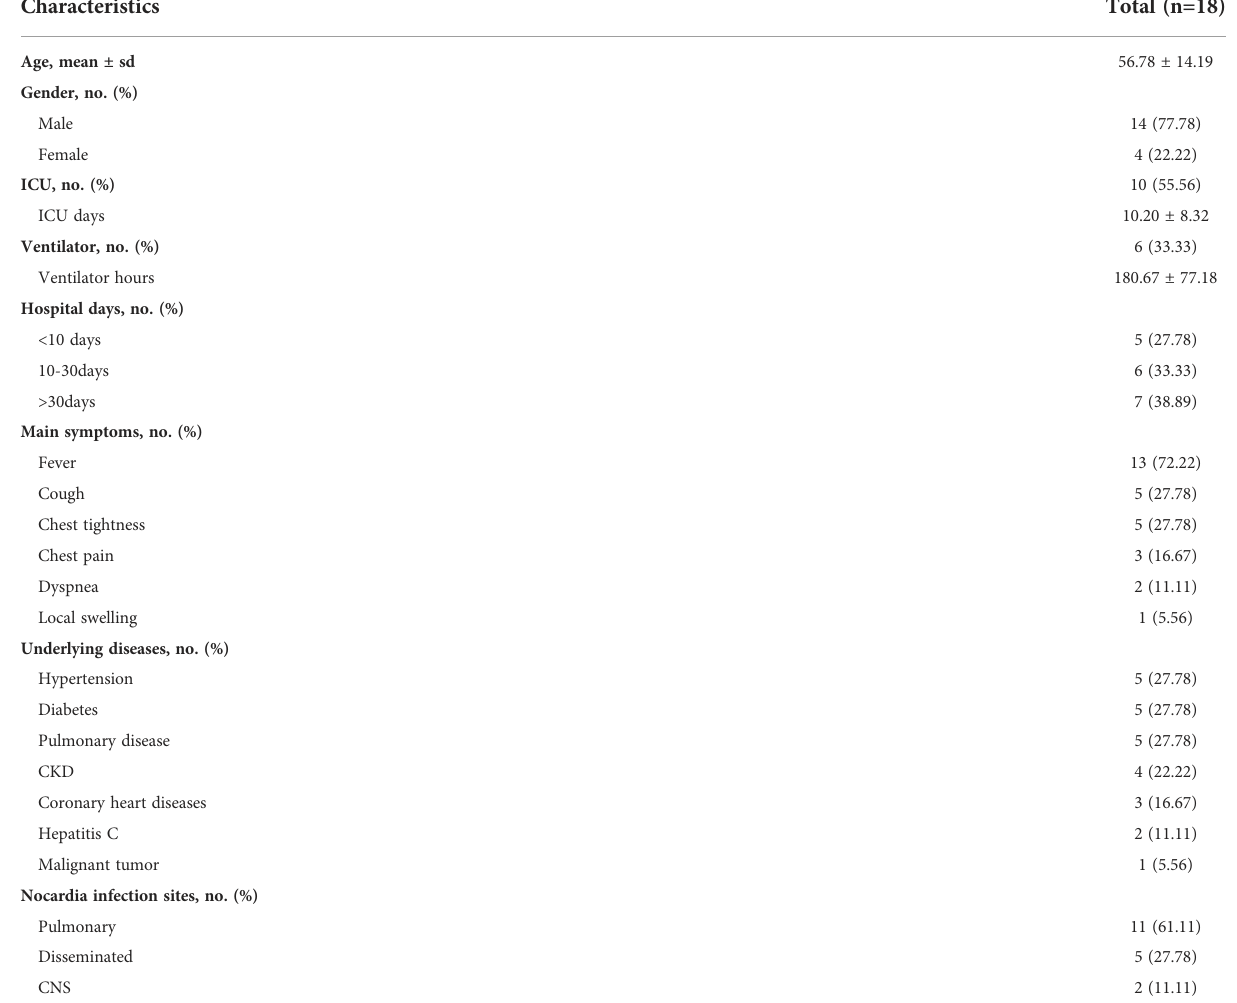
TABLE 1 Patients ’